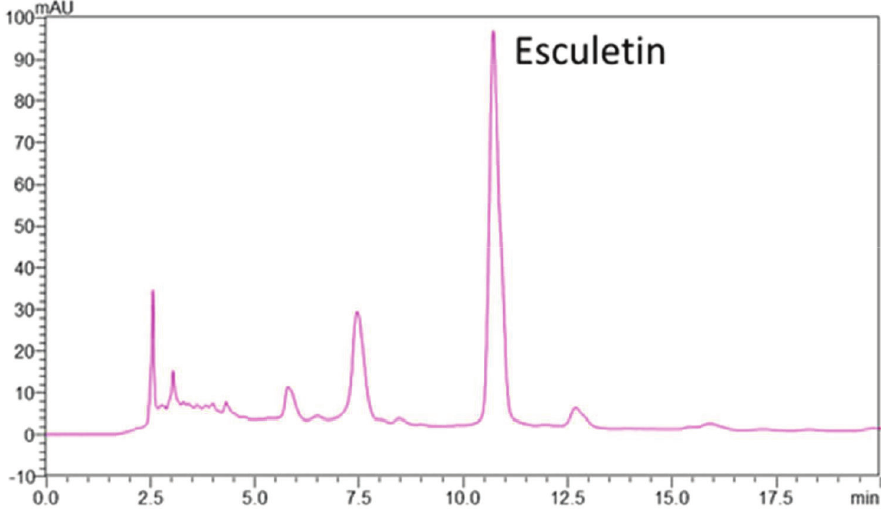
FIGURE 2 - Chromatogram of the esculetin (retention time: 10.8 min) in the Erding extract at the detected wavelength, 353